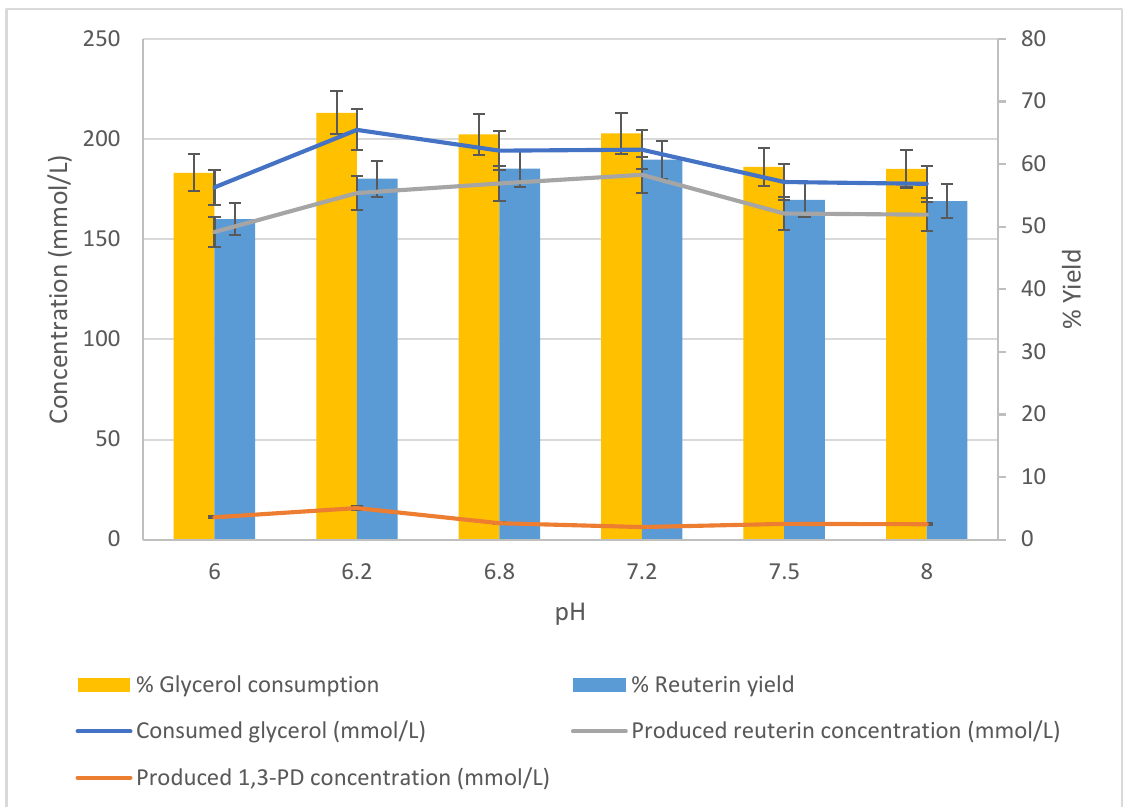
Figure 5. Effect of pH on reuterin production.